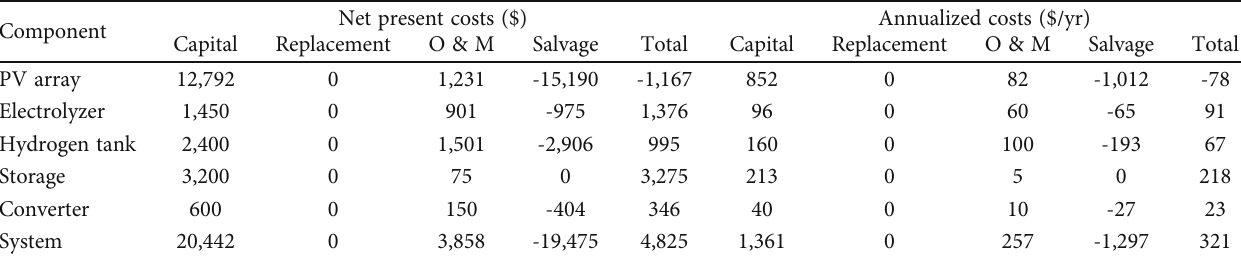
Table 8: Present worth and annualized value of all costs over 10